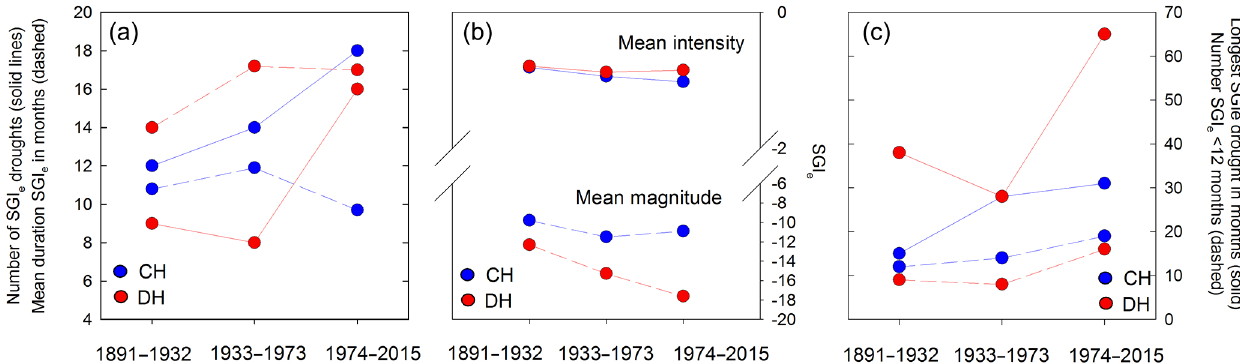
Figure 6. (a) Change in total number of groundwater drought episodes and mean duration of SGIe at CH (blue) and DH (red) for the periods 1891–1932, 1933–1973 and 1974–2015. (b) Change in mean intensity and mean magnitude of groundwater drought episodes over the three analysis periods at CH and DH. (c) Change in maximum duration of SGIe and number of episodes of groundwater drought less than 12 months in duration.